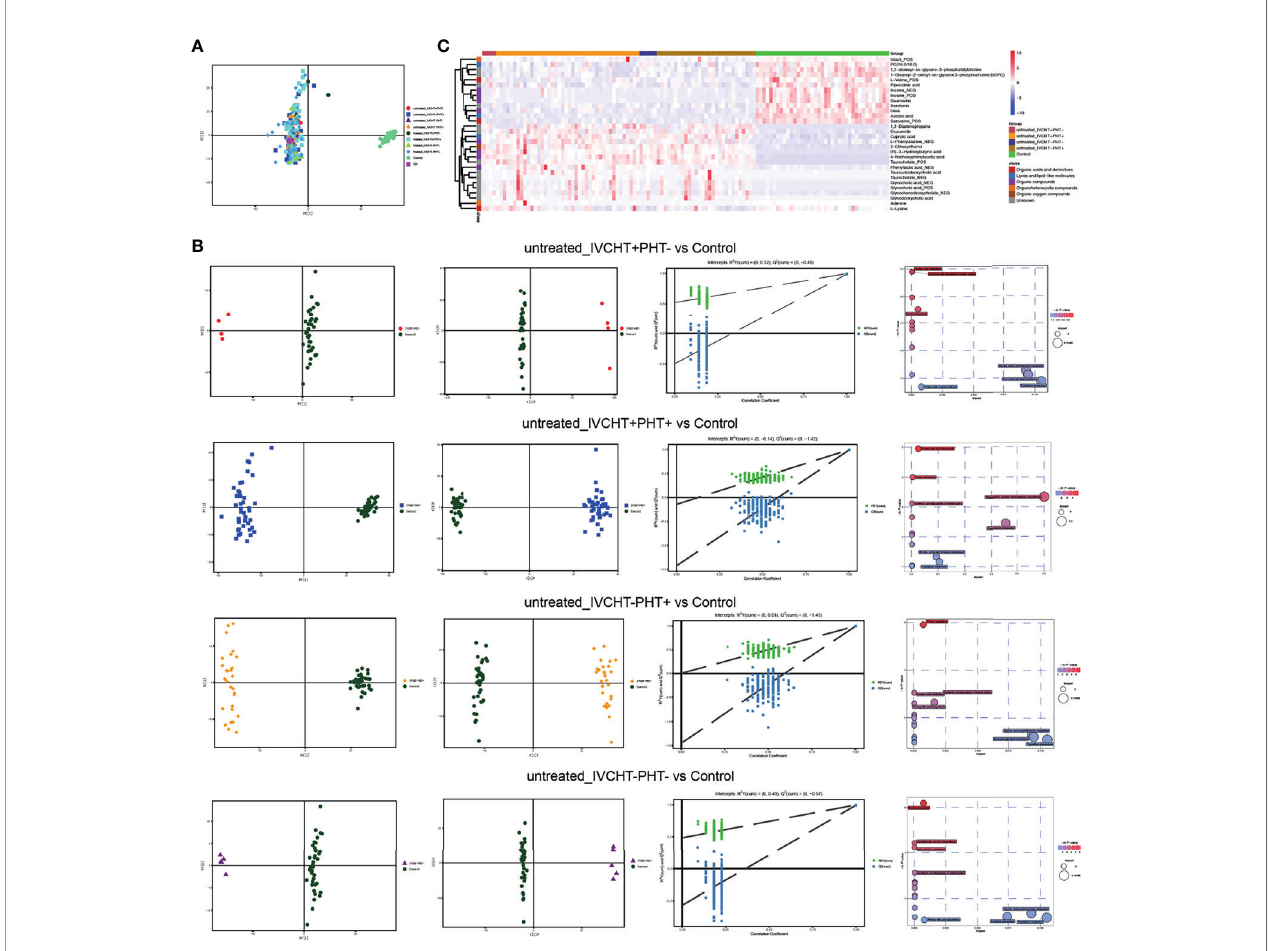
FIGURE 2 | Alterations in serum metabolite levels in patients with B-CS: (A) PCA scores plot of data from a metabolomics scan of serum samples from B-CS patients with those from healthy controls. (B) Multivariate analysis of different untreated B-CS status (IVCHT+PHT-, IVCHT+PHT+, IVCHT-PHT+ and IVCHT-PHT- B- CS patients) with healthy controls. PCA and OPLS-DA scores plot with permutation-test (n = 200) clearly distinguished B-CS group from healthy controls. MetPA analysis highlighted the potential importance of distinct pathways that comprised the human metabolome that were represented by metabolites associated with B- CS. Each bubble present on pathway as well as the colour and size of each circle was based on P values and pathway impact values, respectively. (C) Heatmap of 30 signi fi cant metabolites in B-CS patients vs. healthy controls. (VIP > 1, q-value < 0.05, and fold change value > 1.2 or < 0.83.) B-CS, Budd-Chiari syndrome; KEGG, Kyoto Encyclopaedia of Genes and Genomes; PCA, principal components analysis; OPLS-DA, orthogonal partial least squares discriminant analysis; MetPA analysis, metabolomics pathway analysis; VIP, variable importance in project; IVCHT, inferior vena caval hypertension; PHT, portal